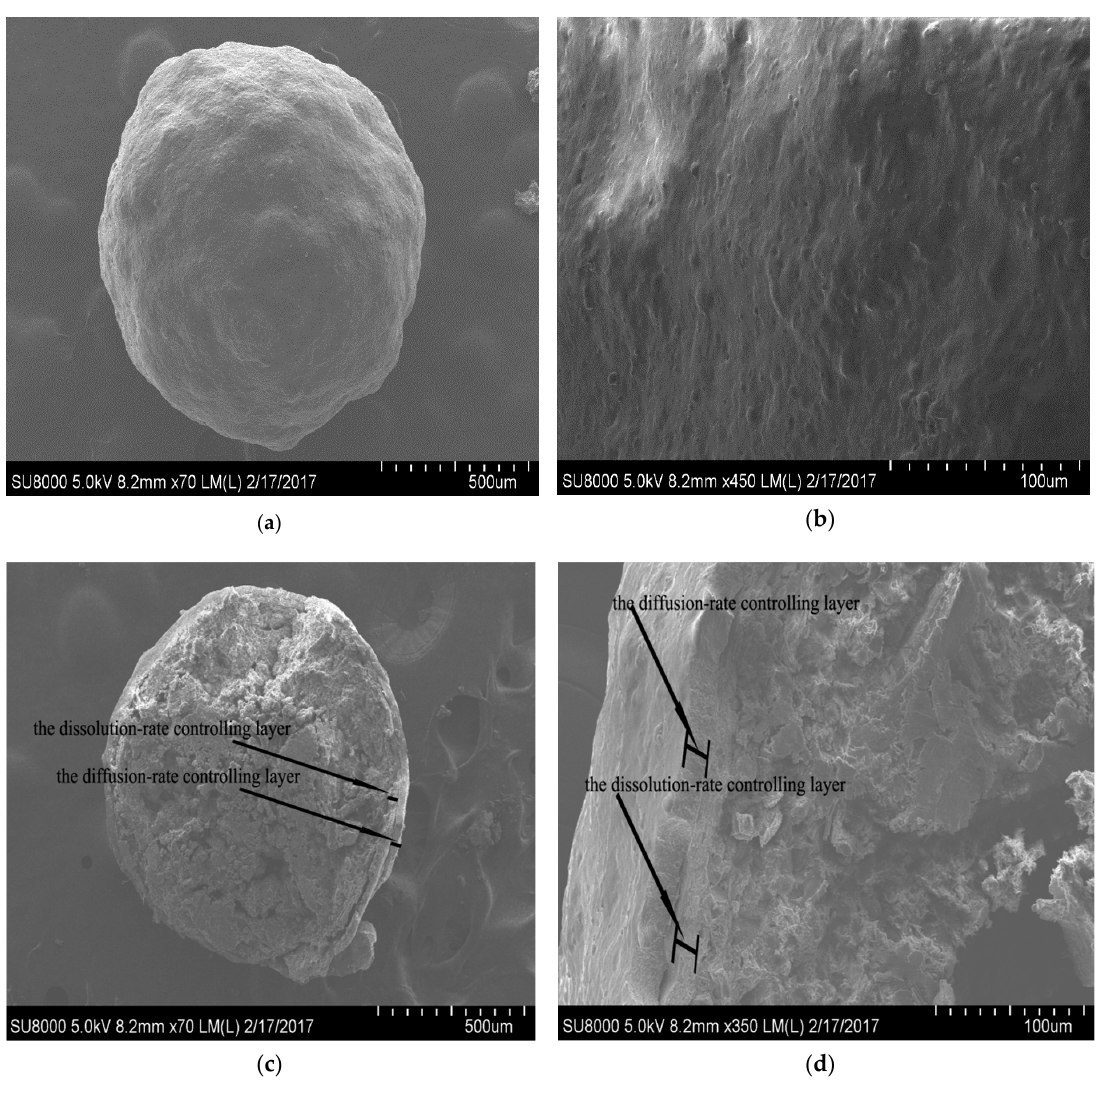
Figure 8. SEM photographs of pellets with double coating layers: ( a ) Surface of sustained release pellets with 70 magnifications, ( b ) surface of sustained release pellets with 450 magnifications, ( c ) cross-section of sustained release pellets with 70 magnifications, ( d ) cross-section of sustained release pellets with 350 magnifications.